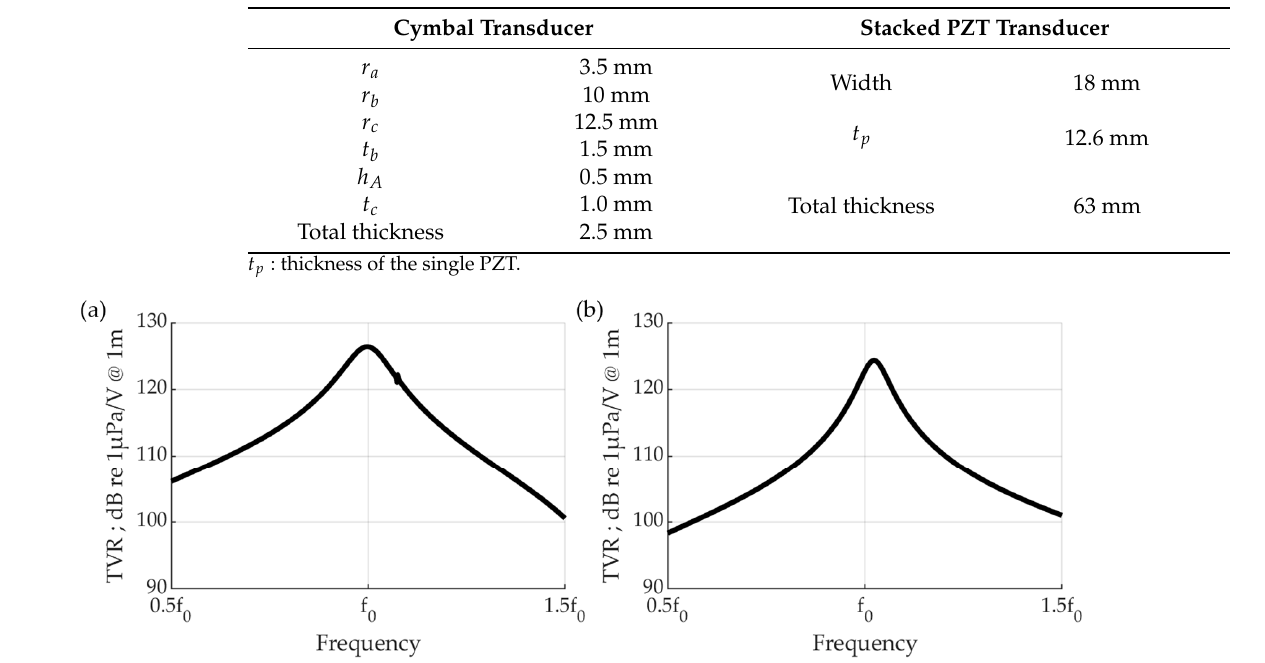
Figure 11. Harmonic response of transmission sensitivity of ( a ) cymbal transducer and ( b ) stacked piezoelectric ultrasound transducer.